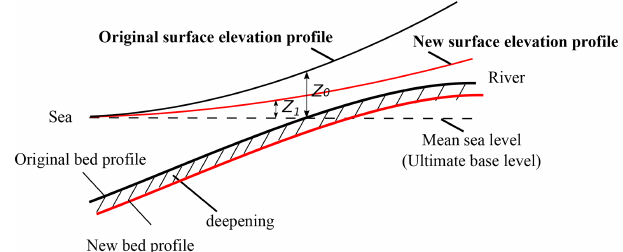
Figure 9. Illustration of the effect of riverbed deepening on the wa- ter level dynamics along the